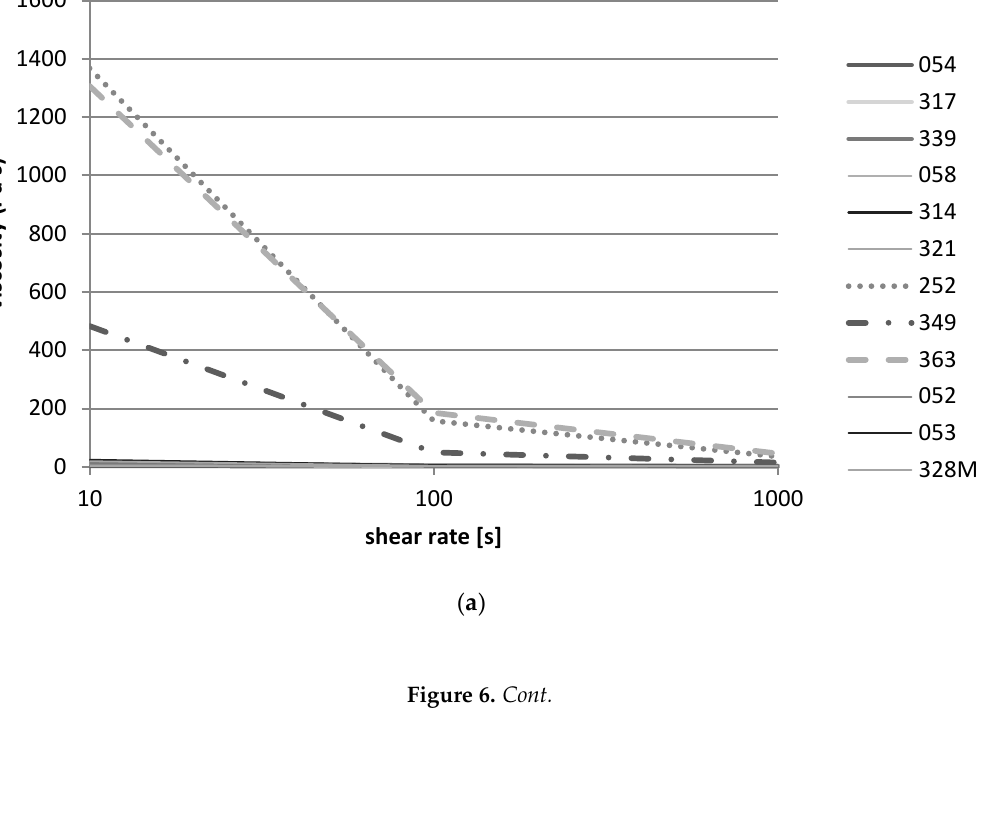
Figure 5. Development of pH of starter culture combinations consisting of the starter strains Lb. helveticus 314, L. fermentum 317, S. thermophilus 252, Lb. delbrueckii 328M, and the yeast S. cerevisiae strain 370 (mixture A) or the lactic acid bacteria strains without the yeast (mixture B) during 24 h fermentation in milk. pH determinations were done as single determinations.